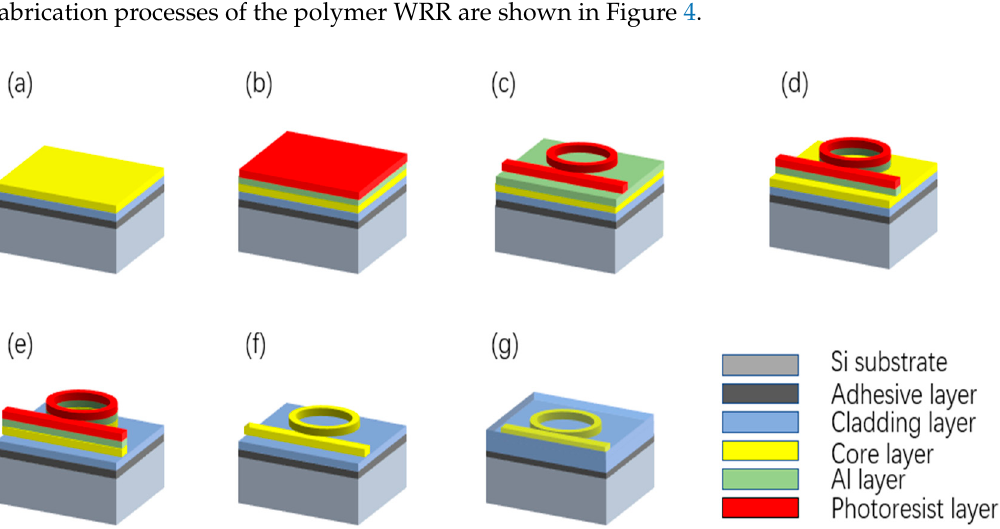
Figure 4. The fabrication process of polymer-based waveguide ring resonator (WRR). ( a ) The core layer was spin-coated on the adhesive layer. ( b ) Al layer deposition and photoresist layer spin-coated on the core layer. ( c ) Photoresist layer patterning. ( d ) Double layers patterning ( e ) Core layer patterning. ( f ) Removing the mask. ( g ) Cladding and annealing.